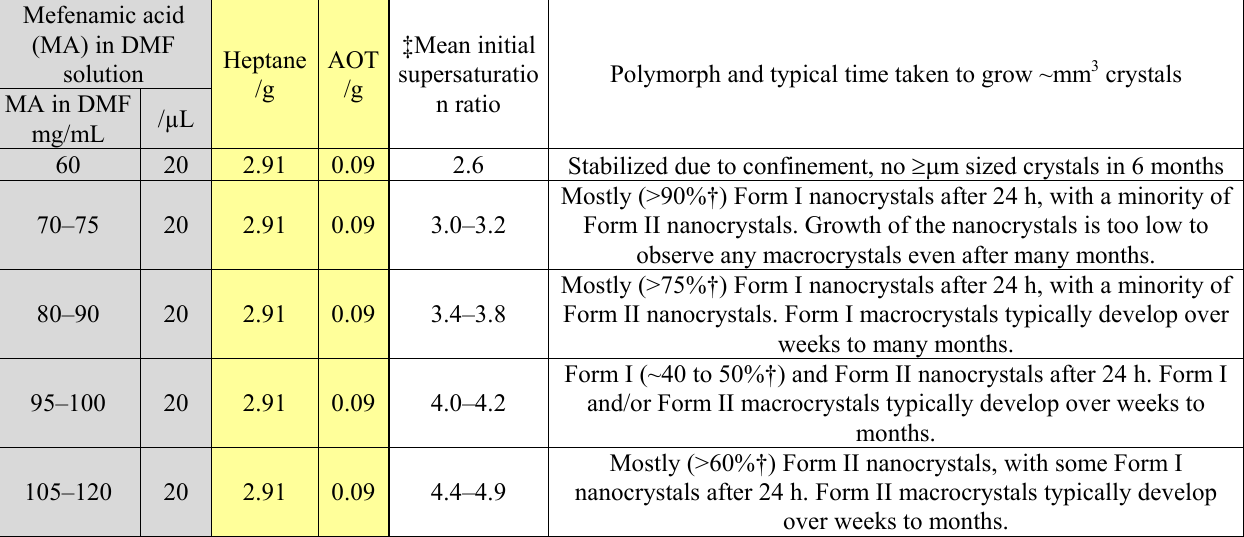
Table 1. Mefenamic acid polymorphs obtained from the DMF microemulsions at 8